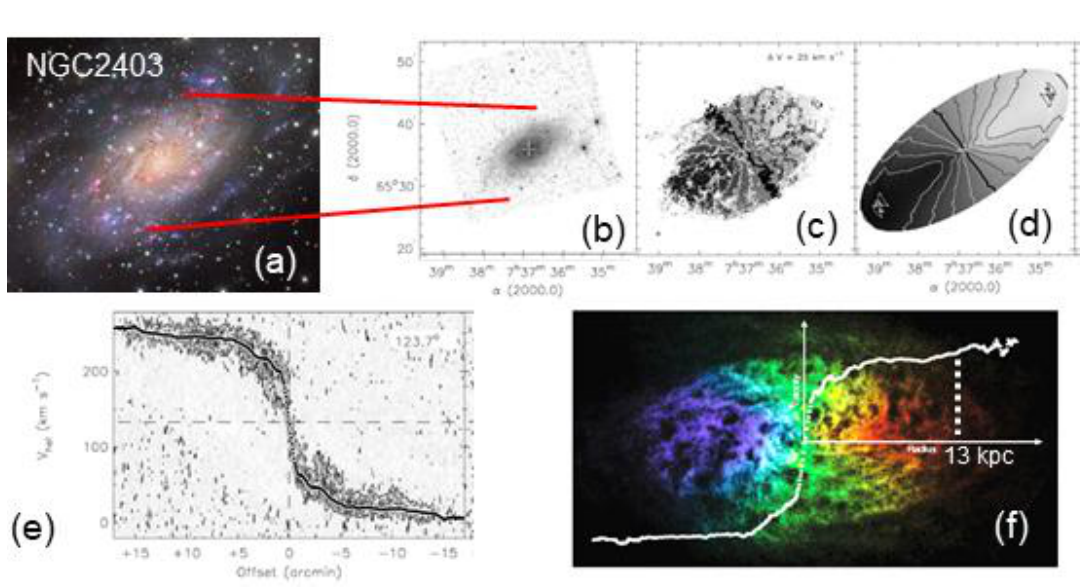
Figure 3. Pictorial essay of an RC extraction by deBlok et al. [53] for a tilted, intermediate sized spiral galaxy from high-resolution study of the 21 cm band using the Very Long Array: ( a ) Detailed, visual image of NGC 2403, type SAB(s)cd, by Göran Nilsson and The Liverpool Telescope group, which is publicly available at https: // commons.wikimedia.org / w / index.php?curid = 63317782. Red lines link this image with the Doppler measurements; ( b ) Image at 3.6 µ m from IRAC Spitzer, showing the multiple spiral arms, which is on the same scale as the Doppler measurements; ( c ) Velocity field derived from fitting Hermite polynomials to the natural-weighted data cube, where the thick line indicates the systemic velocity and the di ff erence between contours is listed; ( d ) The thin disk model of the Doppler measurements with the same grayscales and contours as the data; ( e ) Extracted RC (black curve) along the major axis with the inclinations stated on a velocity-position diagram (gray). Excellent agreement is obtained between the approaching and receding limbs. Panels ( b ) to ( e ) are modified after de Blok et al. (2008) High-resolution rotation curves and galaxy mass models from THINGS. Astrophys. J. 136 , 2648–2719 [53] with permissions by the AAS; ( f ) Color version of the Doppler measurements with superimposed rotation curves. The vertical dashed line is approximately at 13 kpc. Reproduced with permissions from Springer Nature: Nature Astronomy 2, 615-616 , Is there a universal alternative